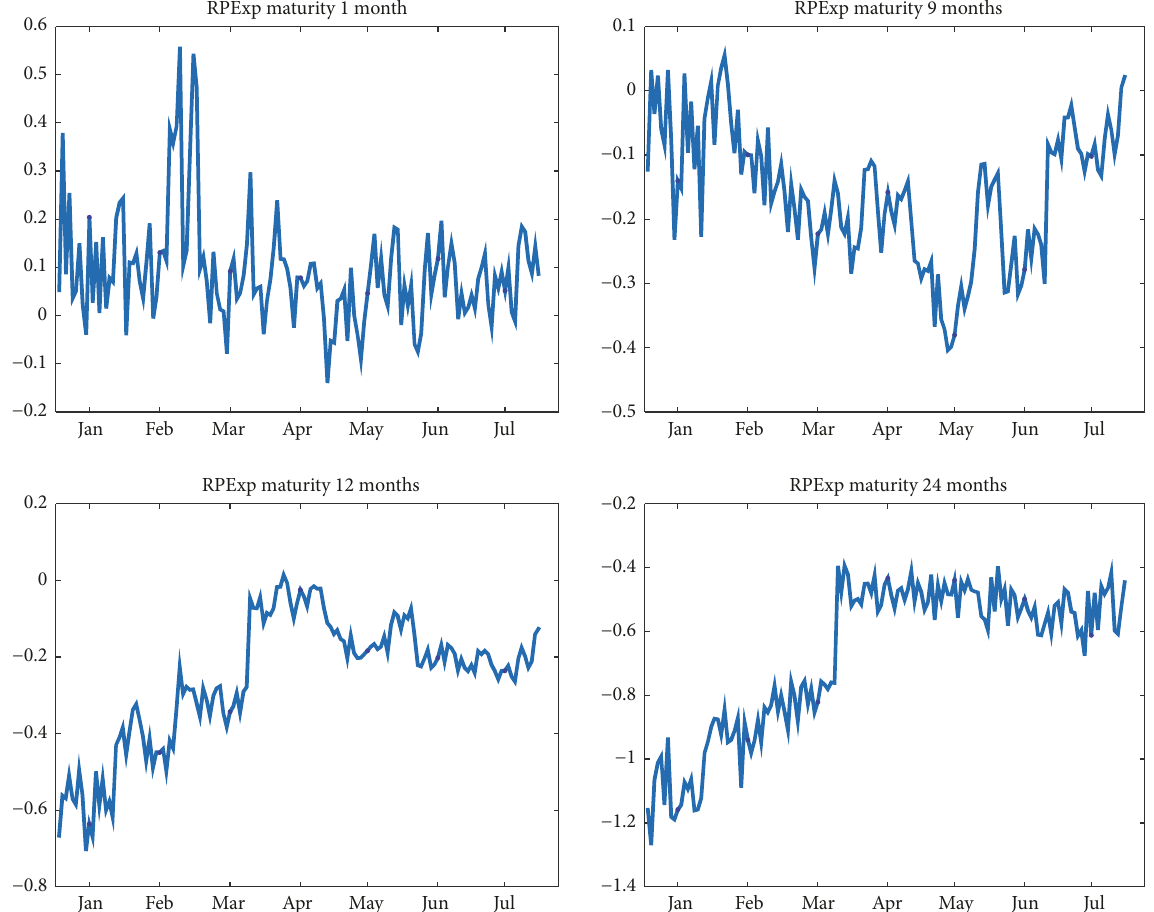
Figure 5: The risk premium for the JDMExp model along the out-of-sample, for maturities 1, 9, 12, and 24